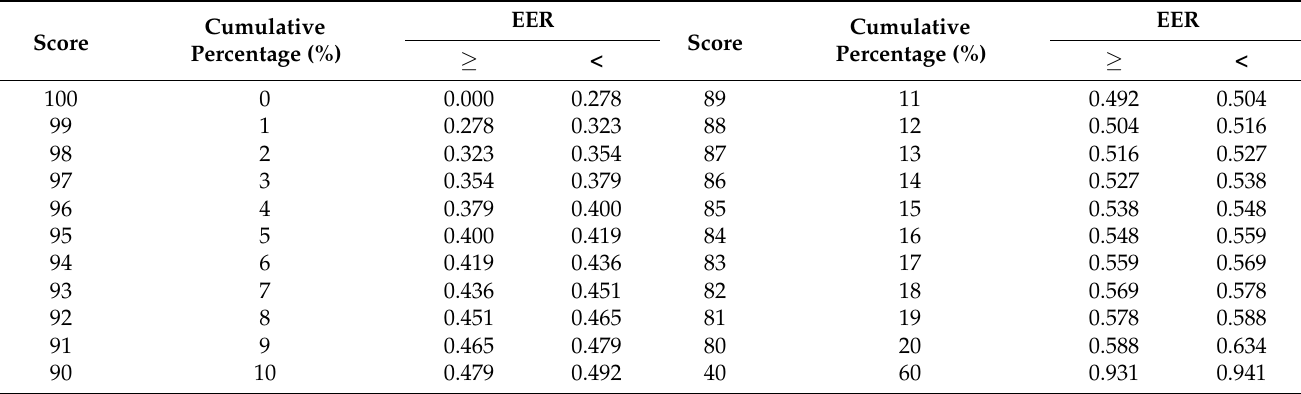
table derived based on the EER calculation results of the survey data. Table 14. Look-up table based on EER for Table 14. Look-up table based on EER for hospitals.